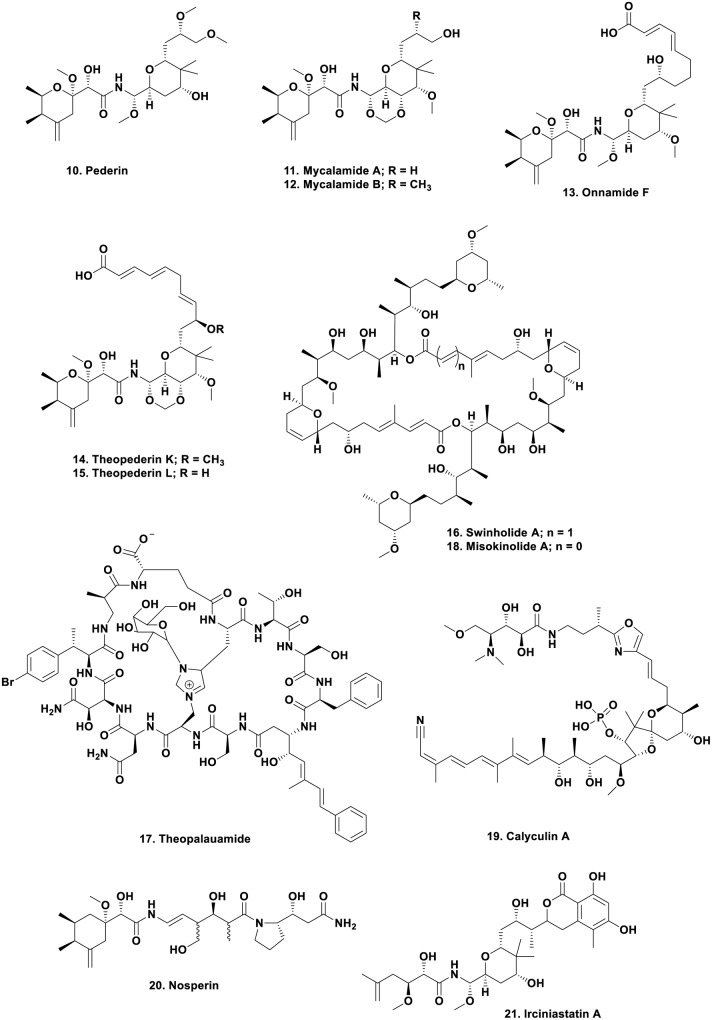
Compounds 10 to 21.